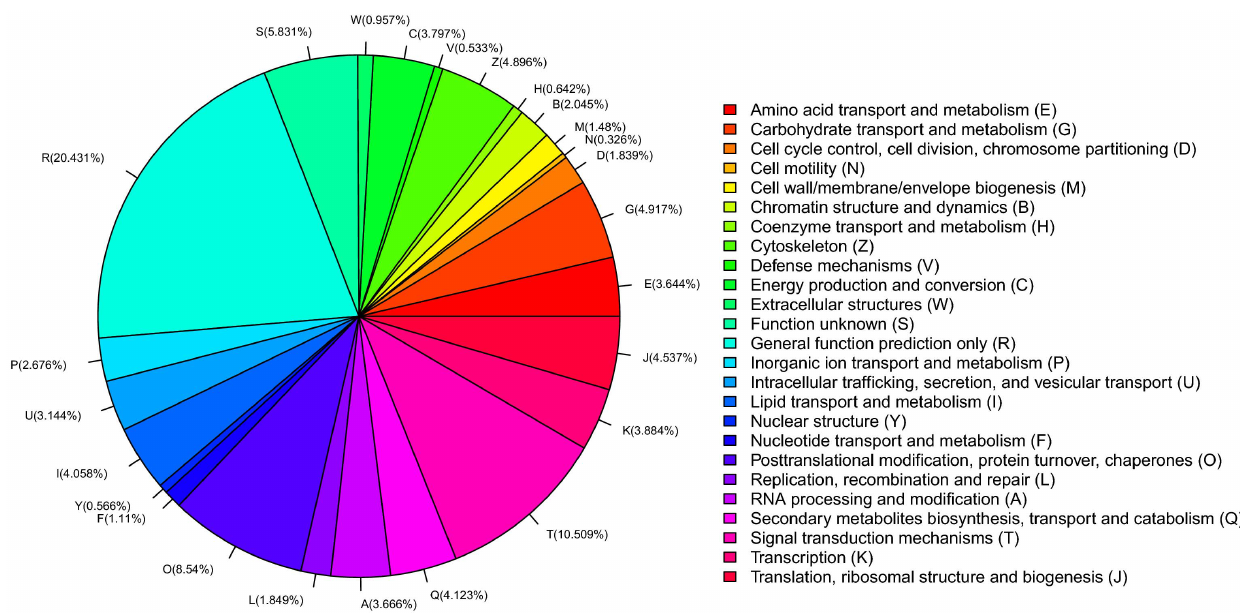
Figure 3. Eukaryotic orthologous groups (KOG) function classification of 52,761 unigenes of Blattellagermanica .